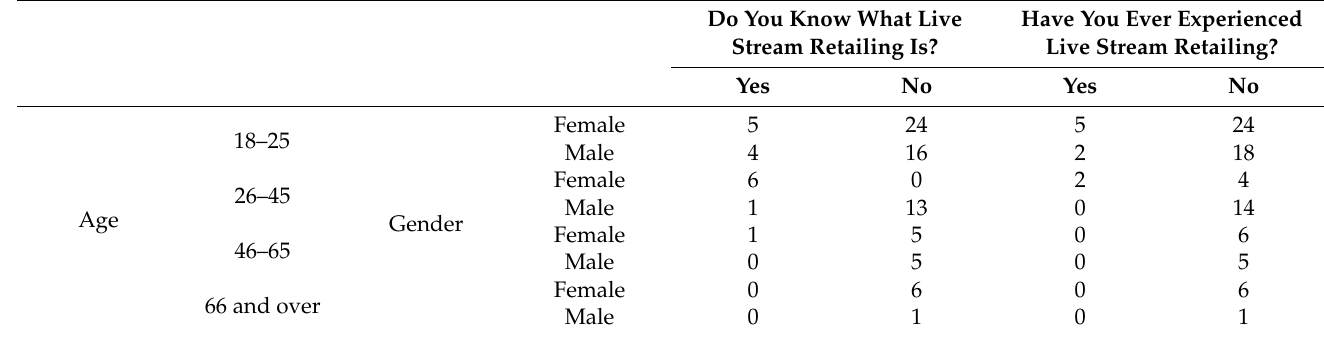
Table 6. Data comparison of Question 10 and